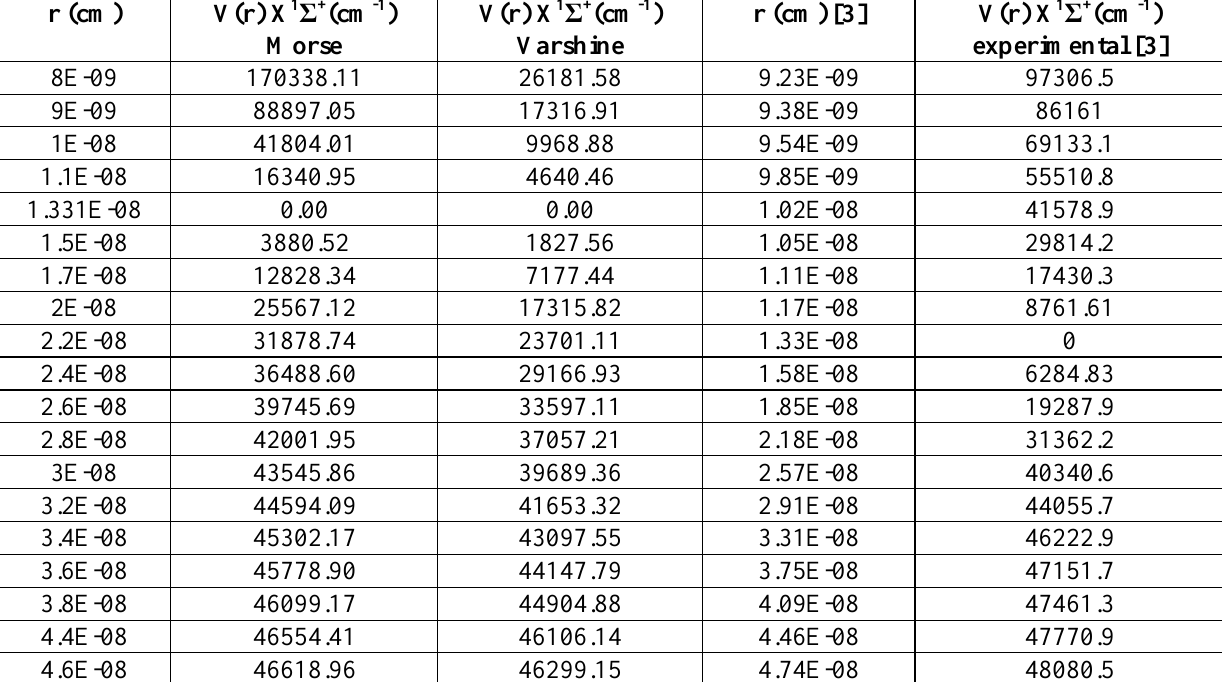
Table 2: Theorttical and experimental Values of potential energy for ground state X 1 Σ + of BeO molecule.